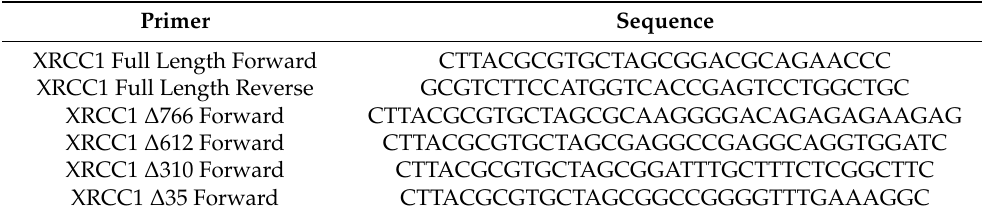
Table 1. Promoters for luciferase assay